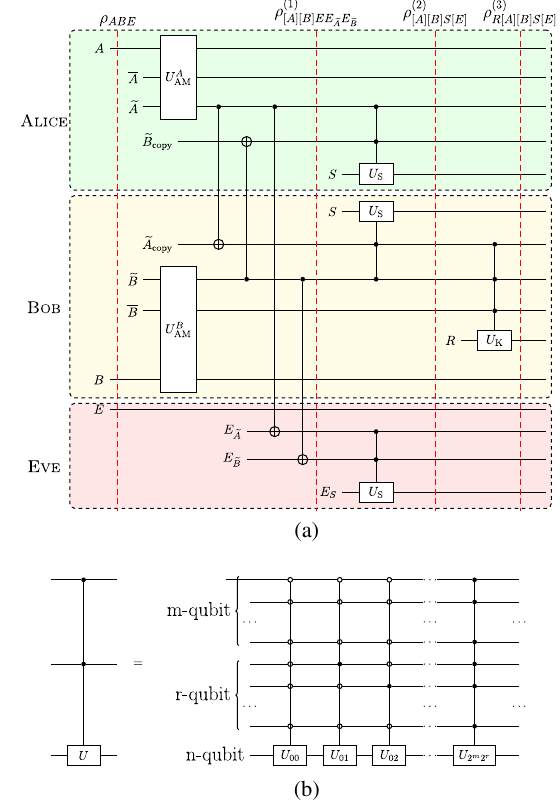
FIG. 11. (a) A schematic circuit diagram for the relevant postprocessing steps: announcement (with measurement), sifting, and key map. Three dashed boxes separate Alice ’ s, Bob ’ s, and Eve ’ s domains. The initial pure state ρ is evolved by an ABE isometry at each step which introduces additional registers and applies a unitary operation on relevant registers. U A , U B , U , S AM AM and U are unitary operations related to the announcement and K measurement, sifting, and key map. (b) An explanation for the controlled unitary operation used in (a). Here, m , r , and n are some sufficiently large integers so that we have a representation of the basis elements for each register in the computational basis of qubits. See the text in Appendix A for more